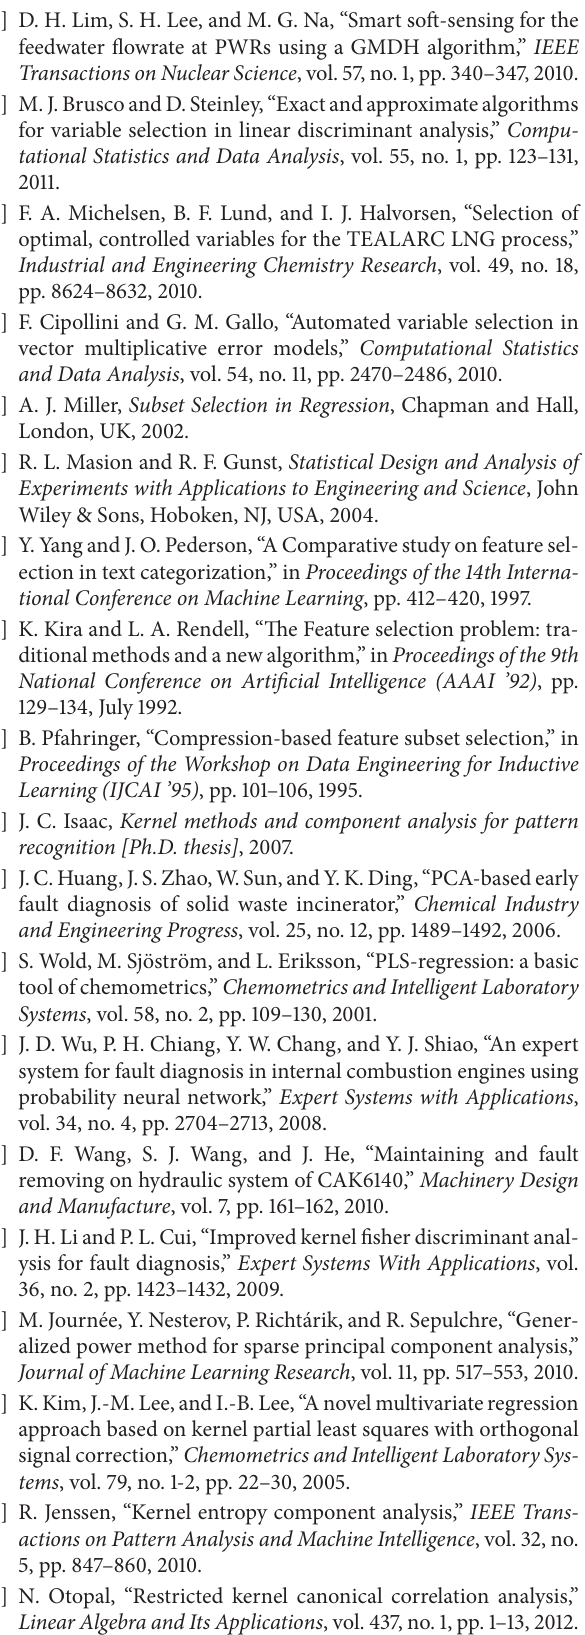
Table 4: The accuracy with different feature sets with testing